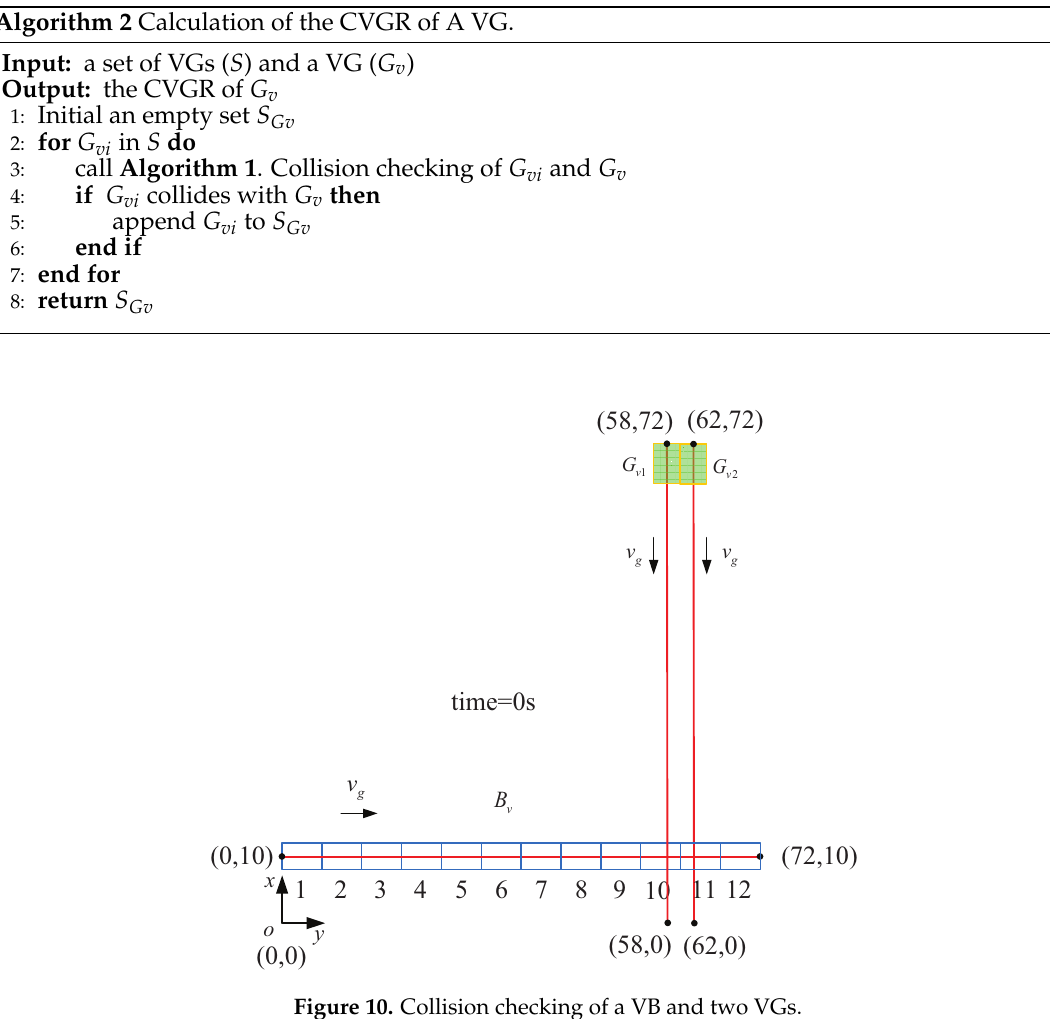
Figure 10. Collision checking of a VB and two